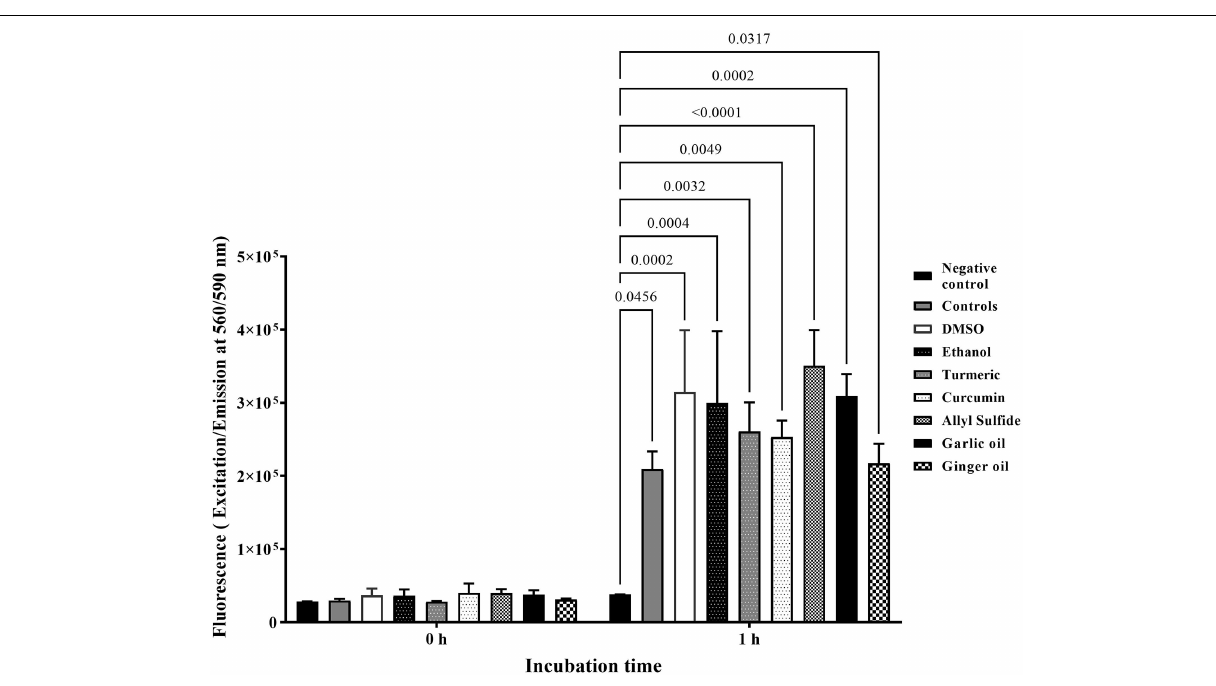
FIGURE 4 | Effect of SIC of phytochemicals on viability and proliferation of ATCC CRL-1590 chicken embryo cells determined using alamarBlue Cell Viability test. Chicken embryo cells were incubated in the presence or absence of phytochemicals for 1 h, and fluorescence was measured. Results are averages of two independent experiments, each containing triplicate samples (mean and SEM). The estimated p -values < 0.05 are included above the